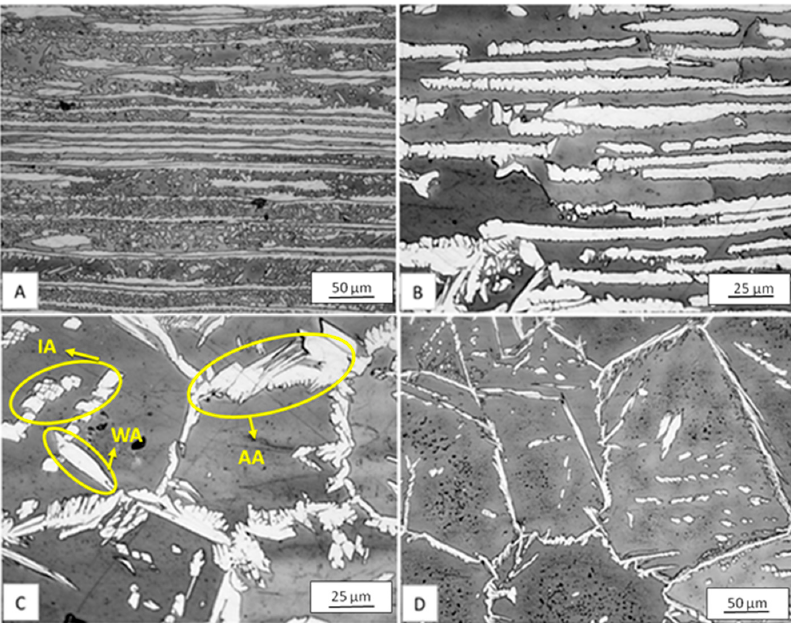
Figure 5. SAF 2304—High heat input: ( A ) BM; ( B ) LT-HAZ; ( C ) HT-HAZ; ( D ) WM; Beraha II Etching. Where: ferrite—dark/dark brown, γ austenite—light brown, WA—Widmanstätten Austenite, IA—Intragranular Austenite, AA—Allotriomorphic Austenite.